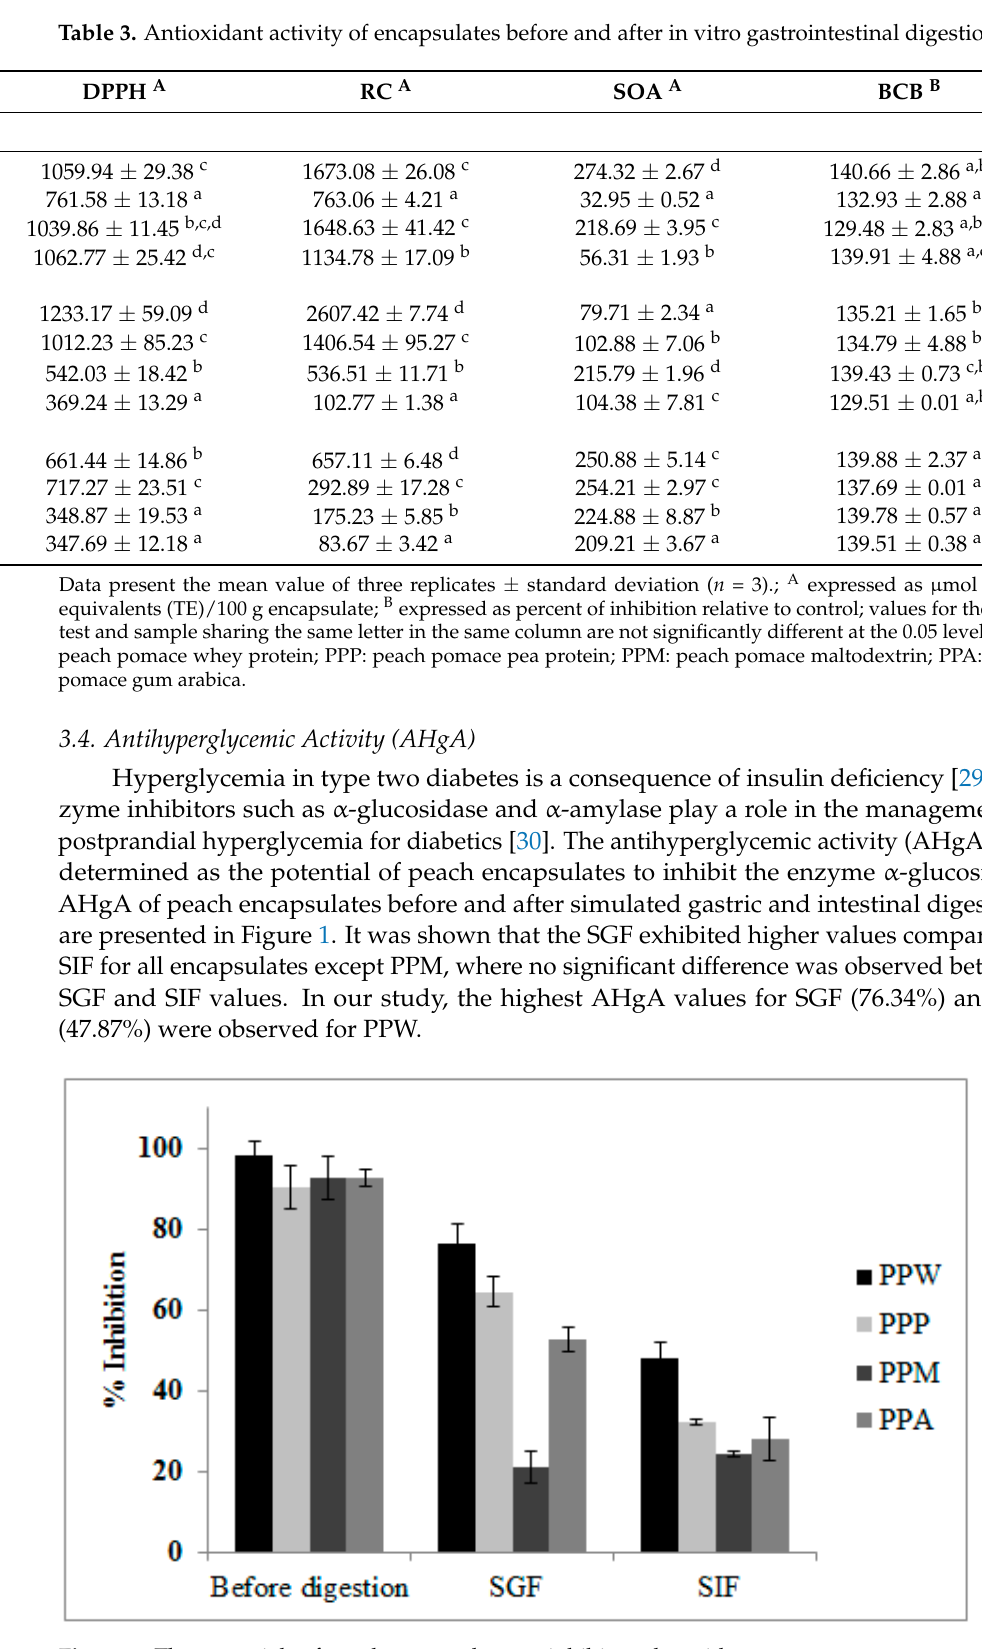
Figure 1. The potentials of peach encapsulates to inhibit α -glucosidase